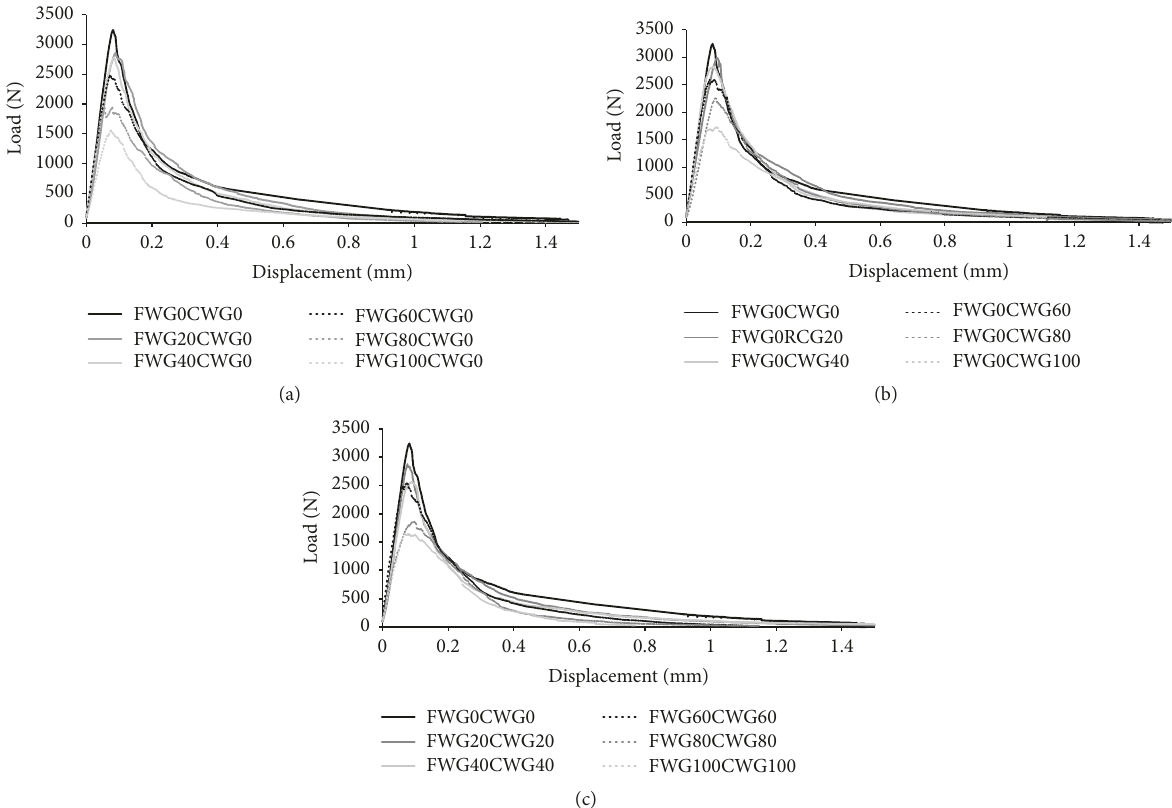
Figure 9: Load versus displacement curve of (a) WGFAs (series I), (b) WGCAs (series II), and (c) WGFAs + WGCAs (series III).